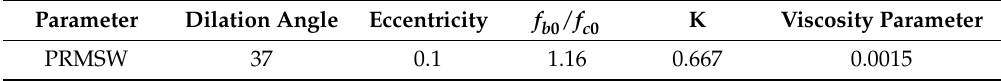
Figure 15. Constitutive model of the steel bars. Table 4. The plastic parameters of the finite element model.